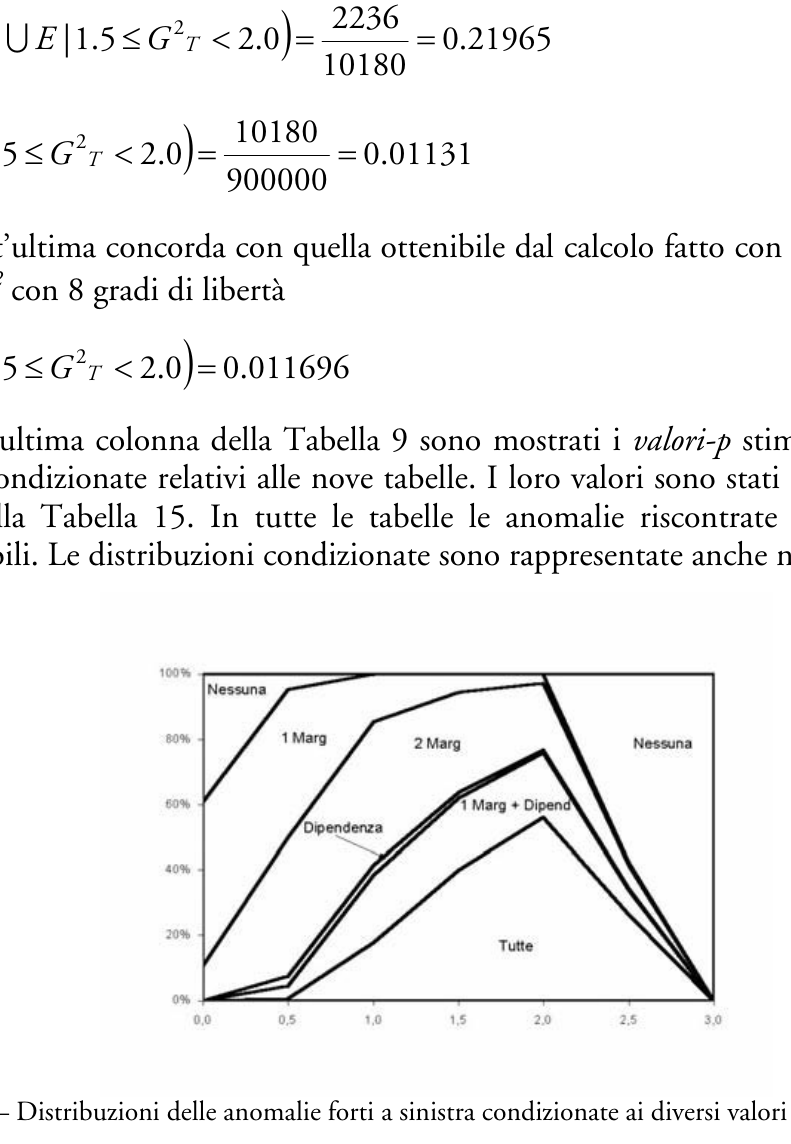
Figura 2 – Distribuzioni delle anomalie forti a sinistra condizionate ai diversi valori di G 2